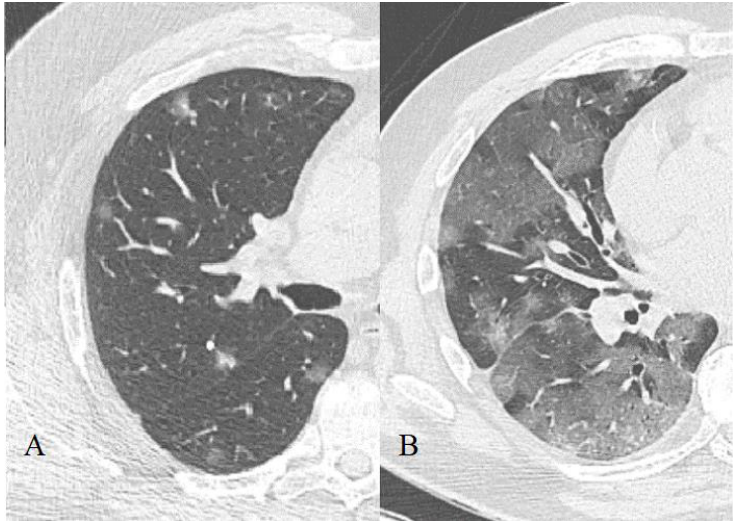
Figure 1. Ground glass opacity, focal ( A ) and confluent ( B ) form.